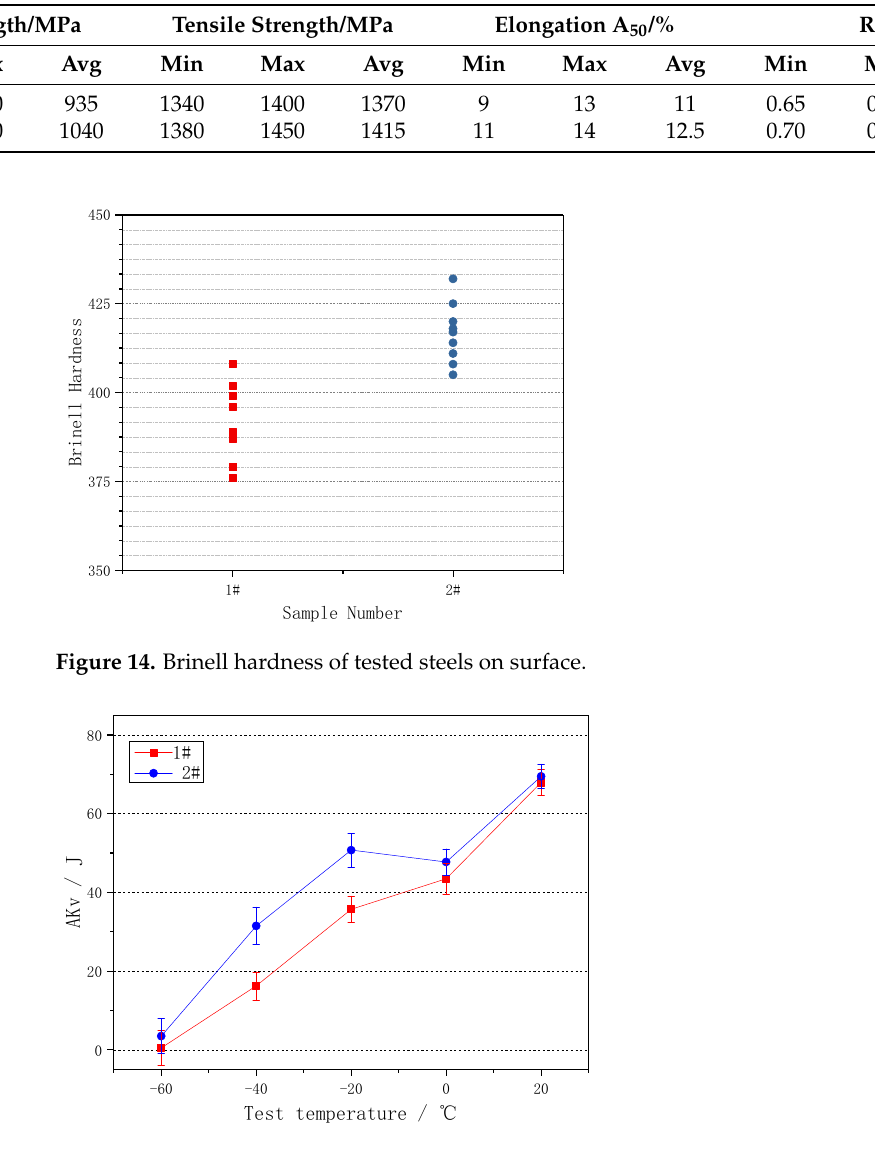
Figure 15. Impact energy of tested steels at series temperature.